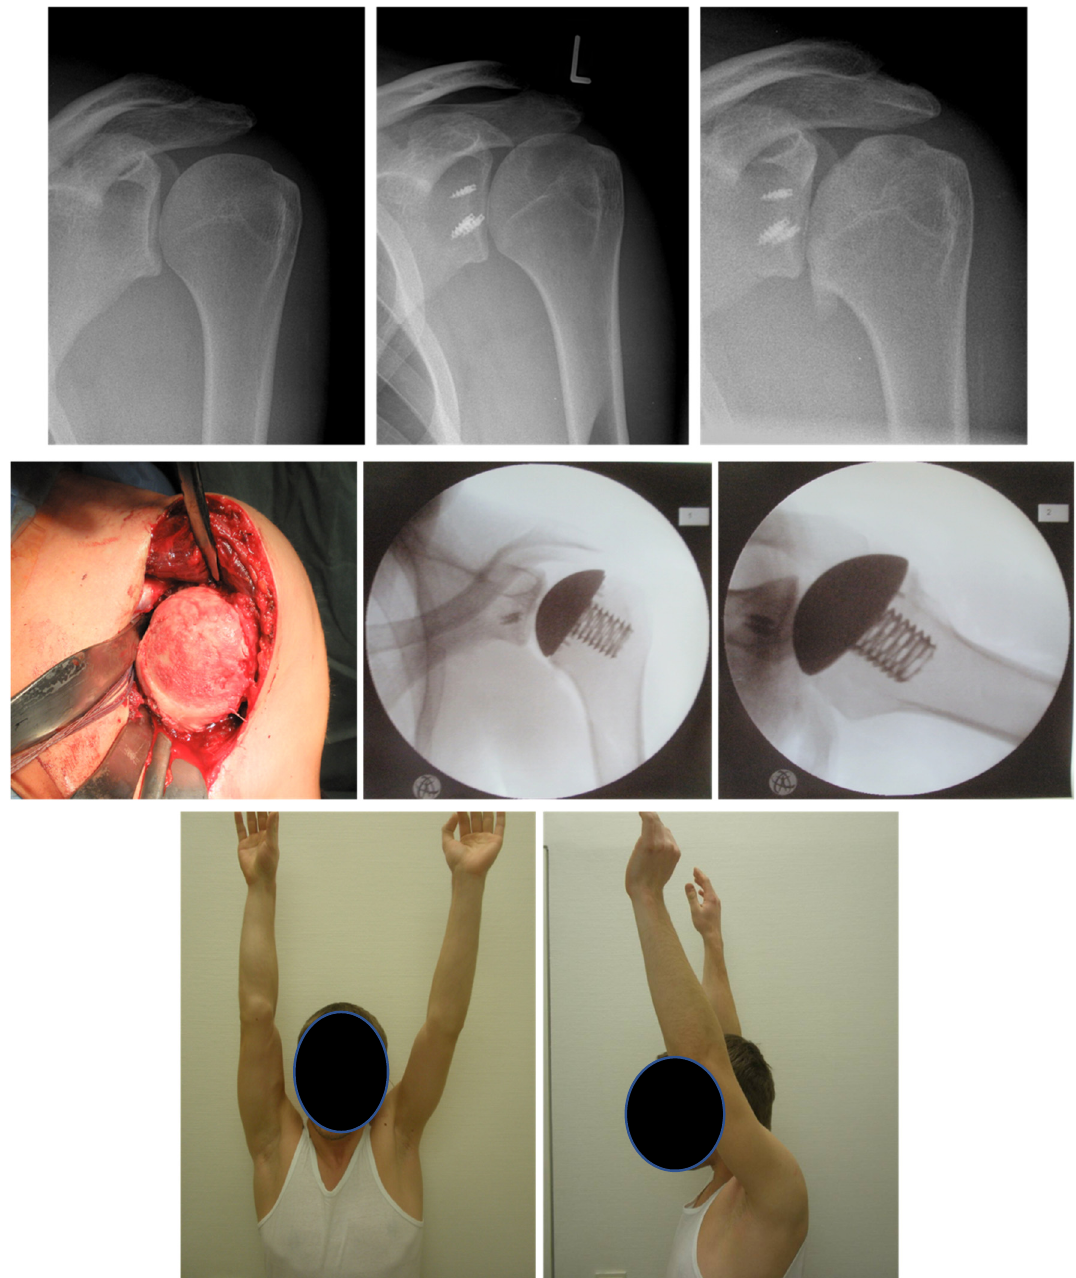
Figure 5. 22-year-old patient with dislocation arthropathy after instability surgery treated with stemless prosthesis. First row : radiographs showing OA after shoulder instability surgery. Second row : intraoperative pictures of hemiprosthesis. Third row : Physical examination and shoulder function at final follow-up.